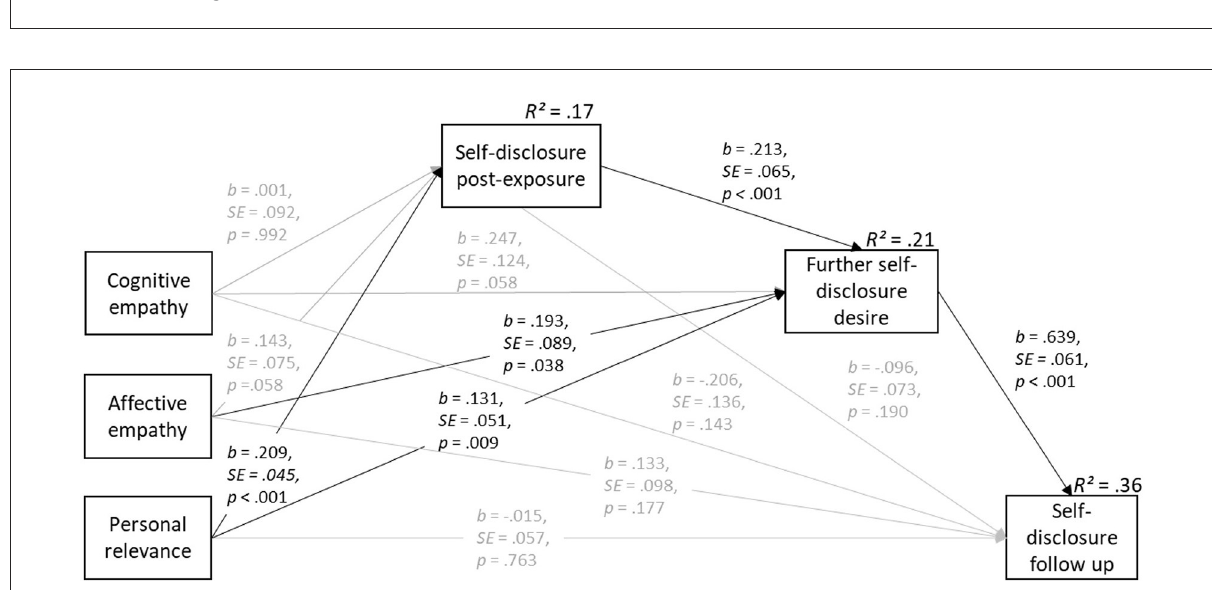
FIGURE4 Effects of cognitive empathy, affective empathy, and personal relevance on self-disclosure follow up (Model 2). N = 328, unstandardized regression coefficients, 5.000 bias-corrected bootstrap samples. Model fit: χ 2 = 6.58, df = 10, p = 0.764; CFI = 1.00; RMSEA = 0.000, 90% CI [0.000, 0.057]; SRMR = 0.021. Covariates: Gender, age, music, shot scale (for all three DVs).